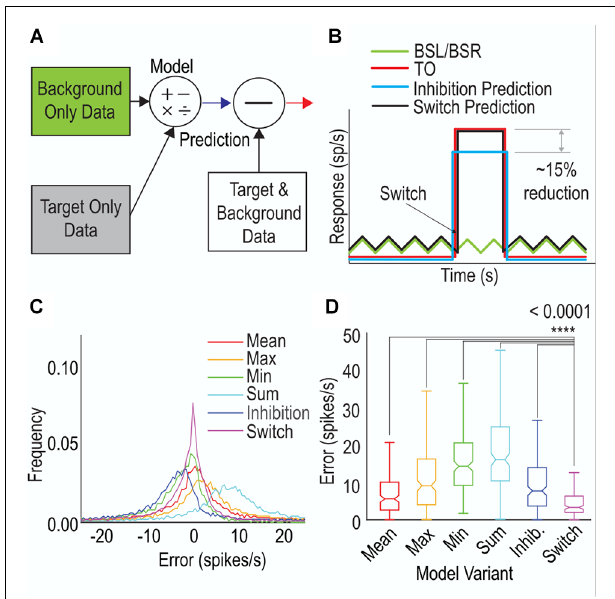
FIGURE 6 | A selective attention model that includes the ability to switch, outperforms other model variants. (A) A schematic of the modeling approach. The target-only (TO) and background-only (BSL, BSR) data are used to predict a background with target response and this is then compared to the background with target data (mean error). (B) Representative illustration of a model variant; Switching (black line) generated from the corresponding TO (red line) and background-alone (green line) responses. The error is the difference between the model output and the physiological background and target responses (not shown). (C) Histogram of errors for the model variants Models include Mean (average of background-only and target-only responses), Max (maximum of background-only and target-only responses), Min (minimum of background-only and target-only responses), Sum (combination of background-only and target-only response and Switch (smaller error between target-only and background-only responses). (D) Boxplots showing mean error across each trial for each model variant. A smaller value represents a better match between model and data. The Switch model is the best match for both CSTMD1 ( p < 0.0001, t -Test, Bonferroni